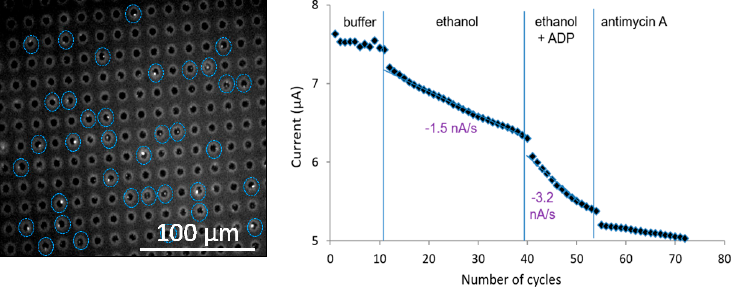
Figure 2. Simultaneous fluorescence microscopy (rear view through the chip) of mitochondria in microwells ( a ) and OCR measurement by cyclic voltammetry at the RNE ( b ). Blue circles on A indicate the microwells filled by one